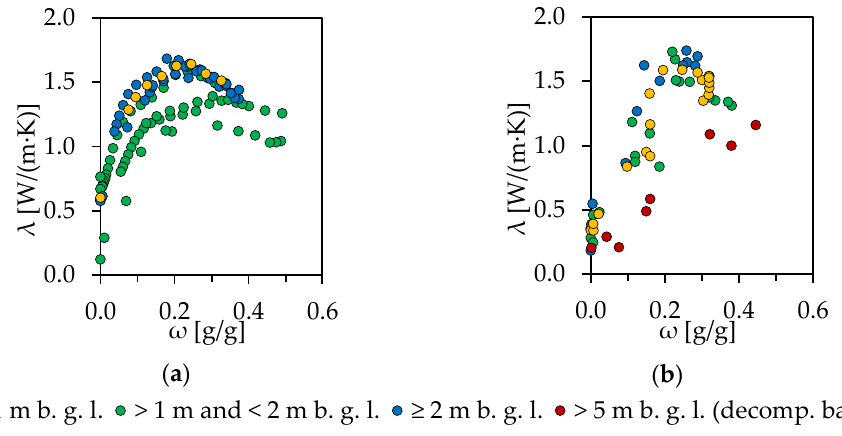
Figure 5. Measured values for λ as a function of gravimetric water content in specific depth intervals for ( a ) the evaporation method and ( b ) the punctual method. In addition, the measured thermal conductivity of decomposed basalt samples (>5 m b. g. l.) is shown in ( b ). For the evaporation method, a maximum of one measuring point per 24 h is displayed. Chart legend is shown in ( c